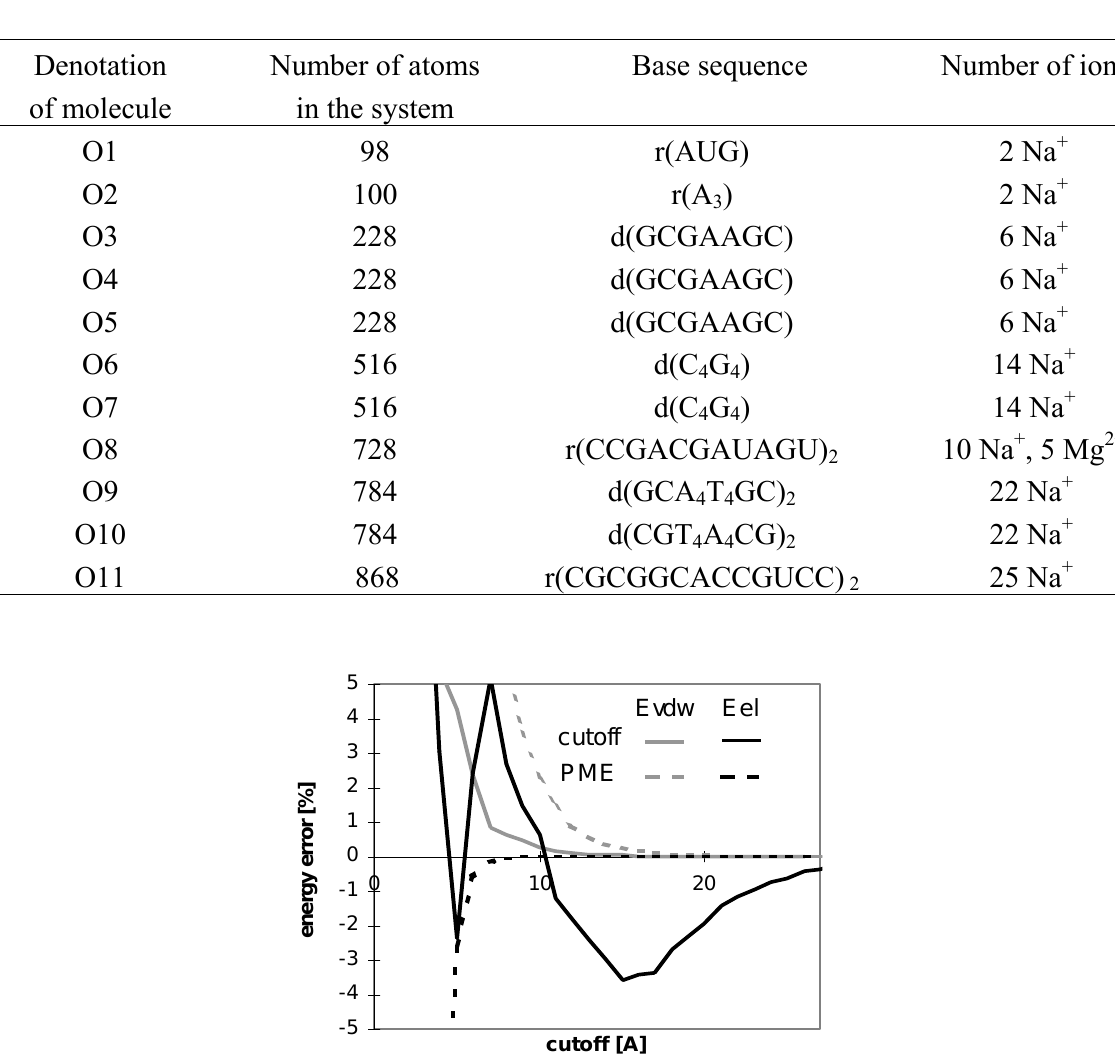
Table 7. Studied oligonucleotides.